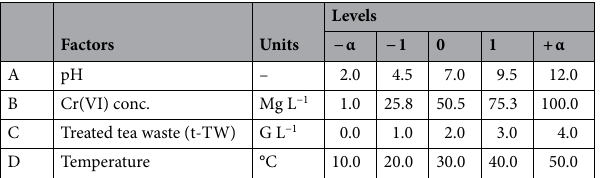
Table 1. Experimental factors for the adsorptive removal of Cr(VI) from water using tea waste treated with ascorbic acid.